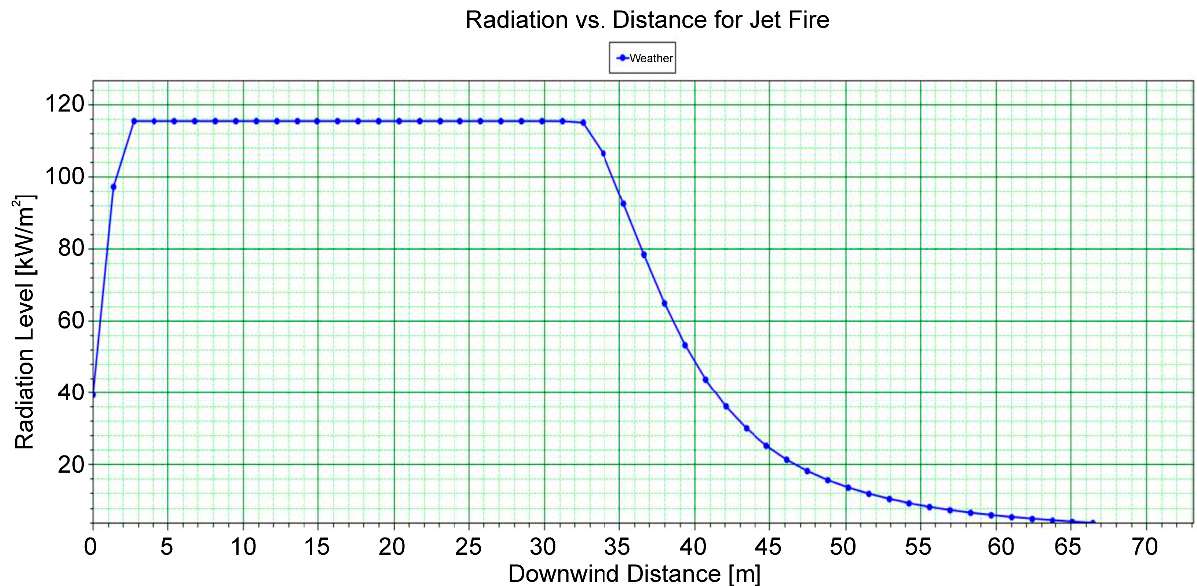
Figure 9. Jet fire according to the damage distance (Phast 7.11).